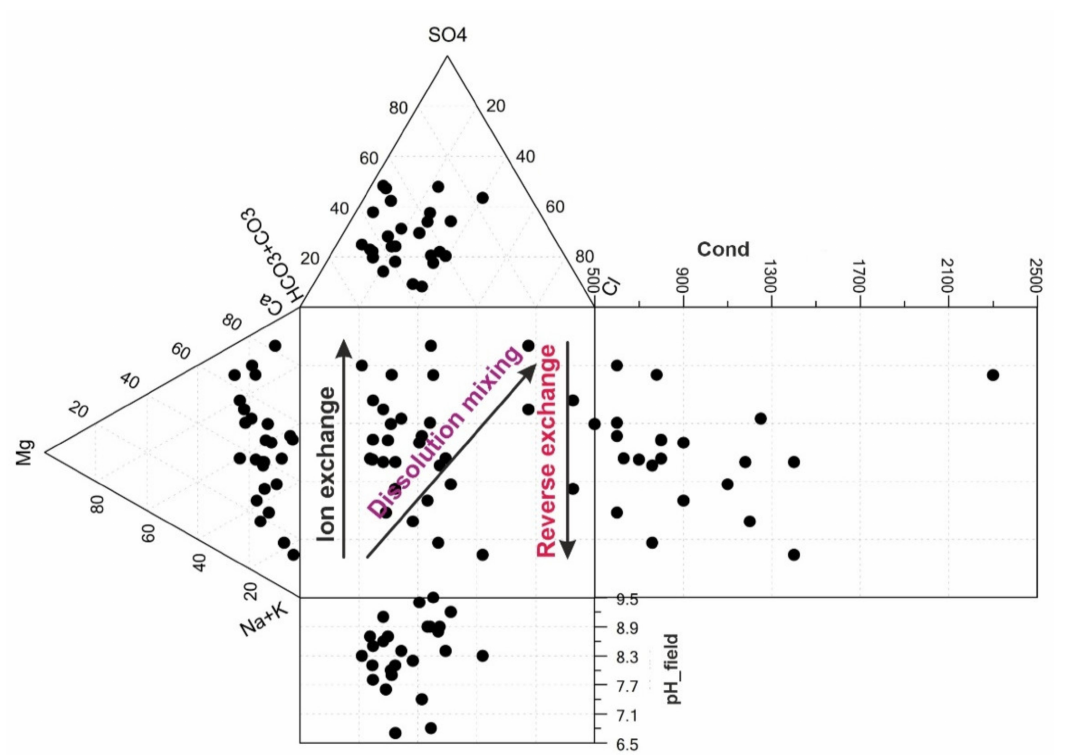
Figure 5. Durov diagram plotted for groundwater